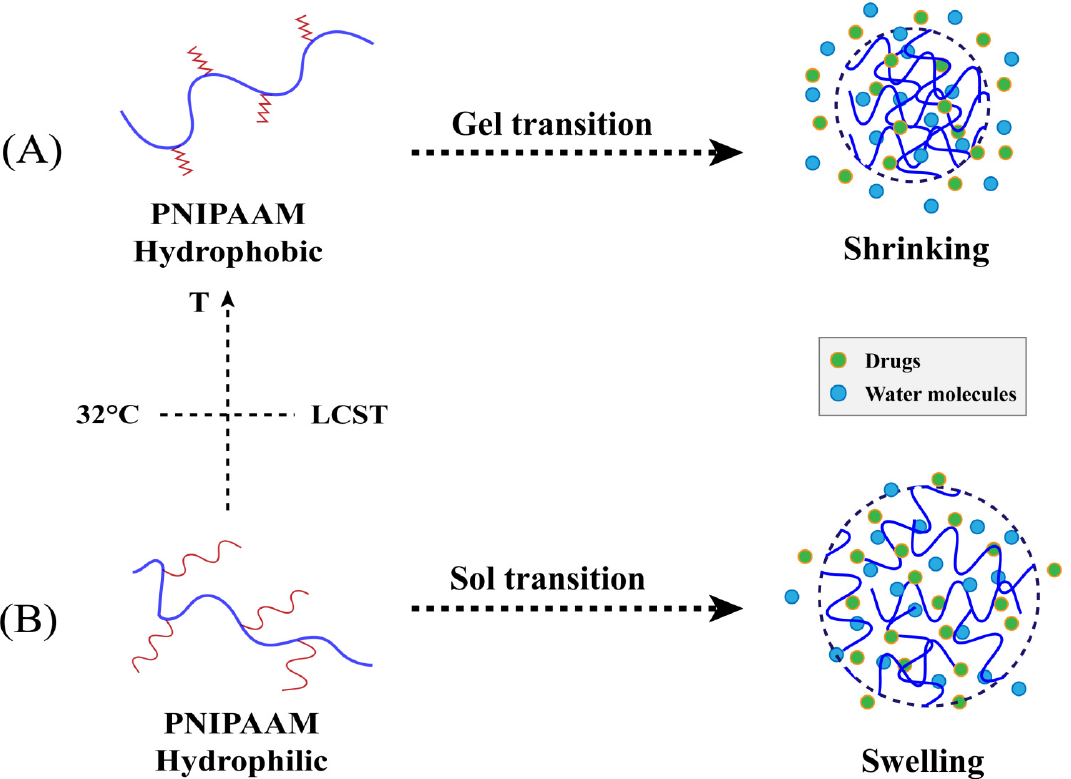
Figure 4. Schematic representation of drug release from temperature-responsive nanogels based on PNIPAAM. ( A ) PNIPAAM above 32 °C, which is above LCST, and nanogels are gel phases, show PNIPAAM. ( A ) PNIPAAM above 32 ◦ C, which is above LCST, and nanogels are gel phases, show hydrophobic properties, shrink and release drug; ( B ) PNIPAAM below 32 °C, which is below LCST, hydrophobic properties, shrink and release drug; ( B ) PNIPAAM below 32 ◦ C, which is below nanogels are sol phases, show hydrophilic properties and swell, and release the drug slowly.